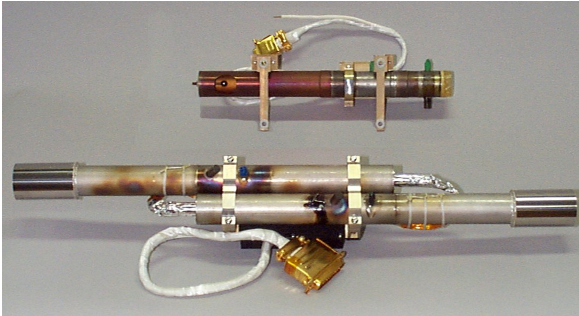
Fig. 5. The PIA photometers with PIA-3 at the top, and the PIA-1/2 assembly